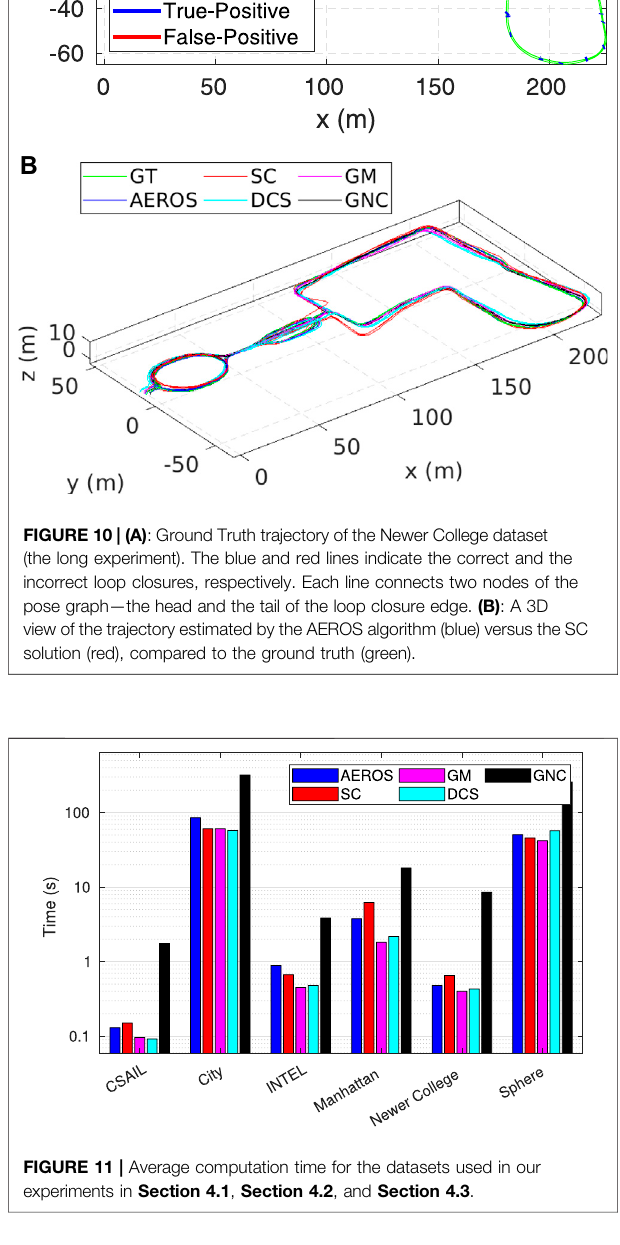
Frontiers in Robotics and AI |